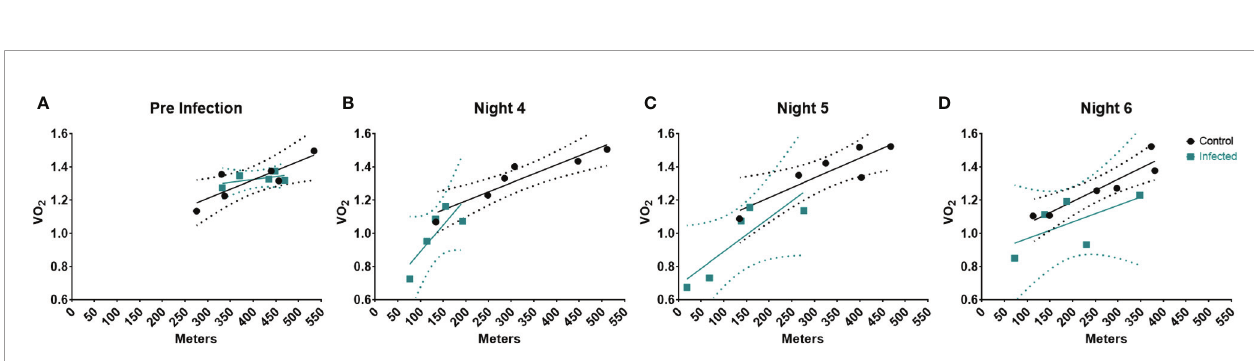
FIGURE 3 | Linear Regression of Activity and VO 2 during the course of the infection. Linear Regression at (A) Pre-infection, (B) Night 4, (C) Night 5, & (D) Night 6 post infection. Dotted regions represent the 95% Con fi dence interval. Control (n = 6), Infected (n =